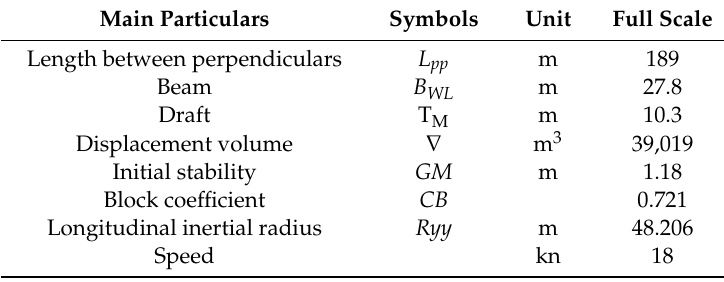
Figure 1. Geometry model of a Yupeng Ship. Table 1. Principle particulars of a Yupeng Ship.